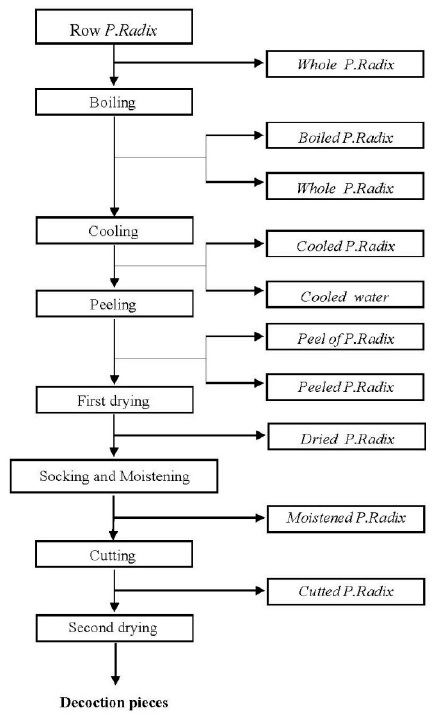
Figure 1. Schematic showing the steps involved in the industrial processing of PRA.